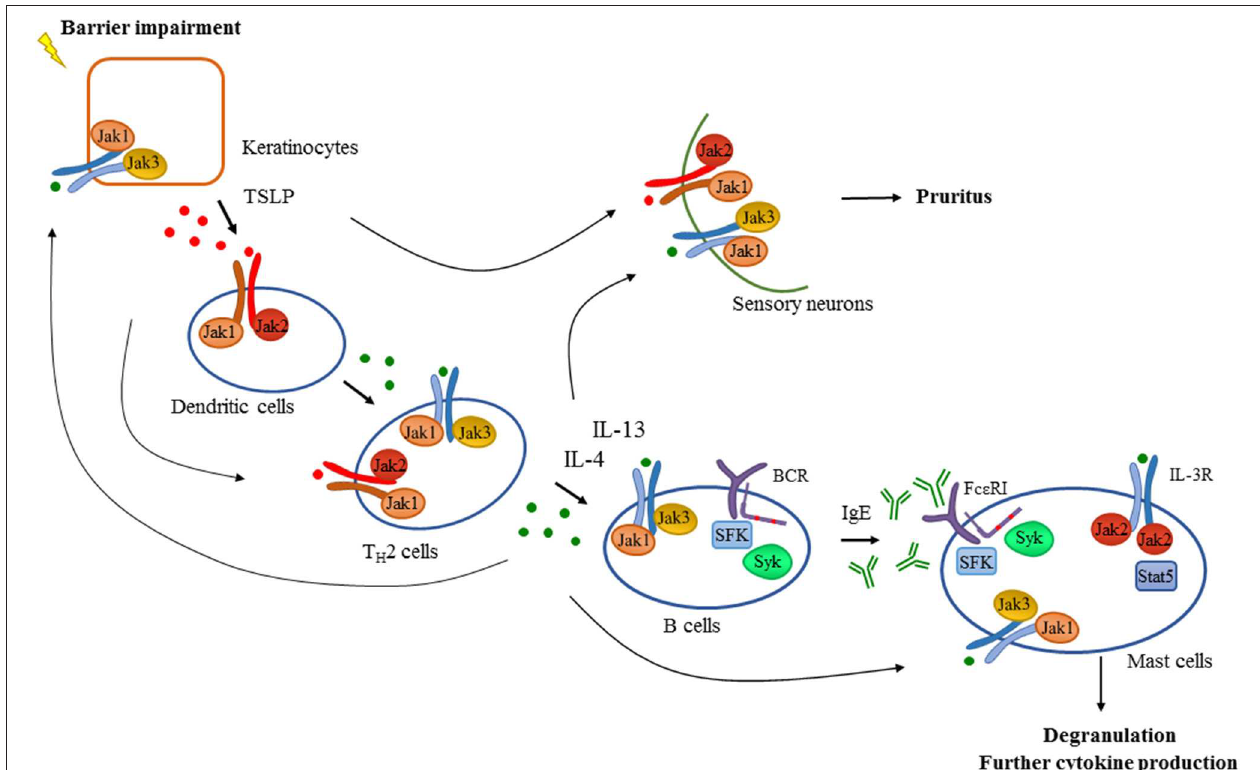
FIGURE 2 | Tyrosine kinases in the development of atopic dermatitis. Barrier impairment is one of the initial steps in the pathogenesis of atopic dermatitis which leads to the production of TSLP by keratinocytes that activates dendritic cells in a Jak1/Jak2 dependent manner in the skin. Proinflammatory mediators produced by dendritic cells and keratinocytes drive the activation and differentiation of CD4 + T cells toward the T H 2 phenotype. Activated T H 2 cells produce several cytokines including IL-4 and IL-13 which promote isotype switch and IgE production in B cells acting through receptors with the common γ chain ( γ c) utilizing the Jak1/Jak3 heterodimer. Additionally, intact B cell receptor (BCR) signaling involving Src-family kinases (SFK) and Syk is essential for normal B cell development. Downstream effector cells like mast cells recognize IgE through Fc ε RI in a Src-family and Syk dependent manner leading to degranulation and the production of proinflammatory mediators contributing to the development of atopic dermatitis. There are several feedback loops and shortcuts in this pathway facilitating inflammation utilizing tyrosine kinases. T H 2 cytokines also promote the activation of keratinocytes and effector immune cells like mast cells requiring intact Jak signaling. Activation of mast cells through IL-3R/Jak2/Stat5 pathway was also found to be important in allergen-induced dermatitis in mice. Furthermore, TSLP and T H 2 cytokines acting through a Jak dependent manner in sensory neurons were found to mediate pruritus in atopic dermatitis in addition to mast cell-derived compounds such as